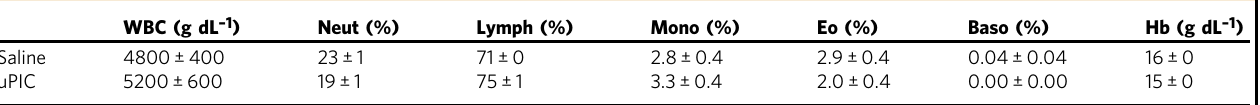
Table 2 Blood counts of mice at 48 h after fi ve systemic administrations (mean ± s.e.m. n =